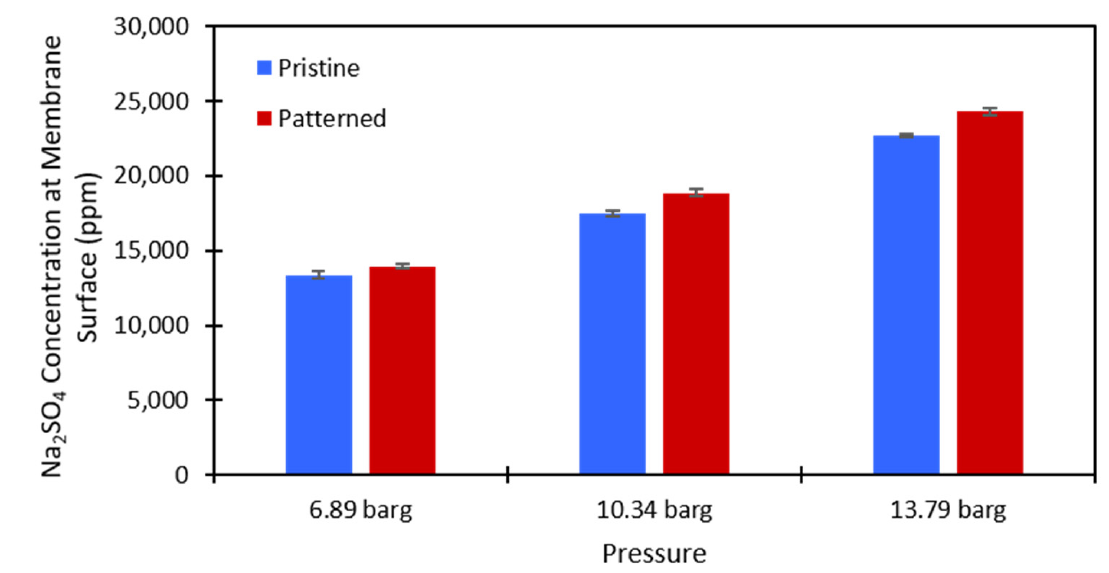
Figure 8. Calculated values of the Na 2 SO 4 concentration at the membrane surface for the 10,000 ppm feed stream. Blue is the pristine NF270 membrane, and red is the patterned NF270 membrane. The error bars represent one standard deviation among at least three membrane samples.